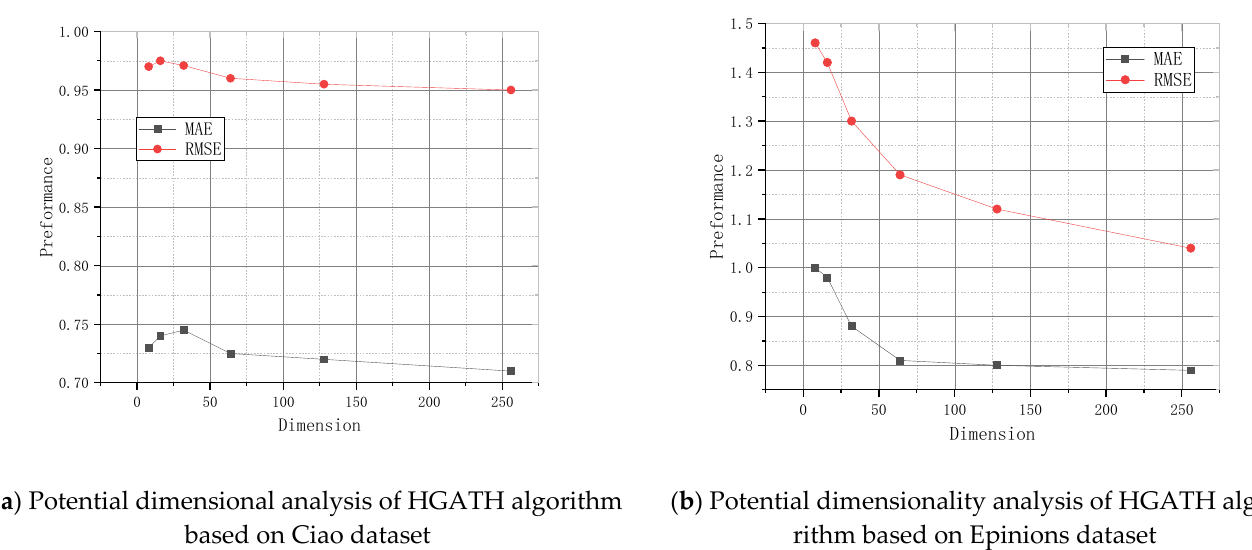
Figure 5. The adaptability of different potential dimensions to the algorithm. ( a ) Potential dimen- sional analysis of HGATH algorithm based on Ciao dataset ( b ) Potential dimensionality analysis of HGATH algorithm based on Epinions dataset.